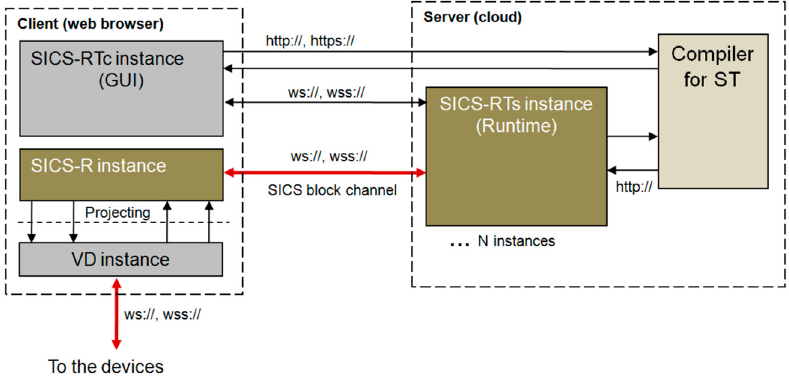
Figure 10. Implementation structure of a SICS SMM controller at runtime (s—server-based part; c—client-based part).